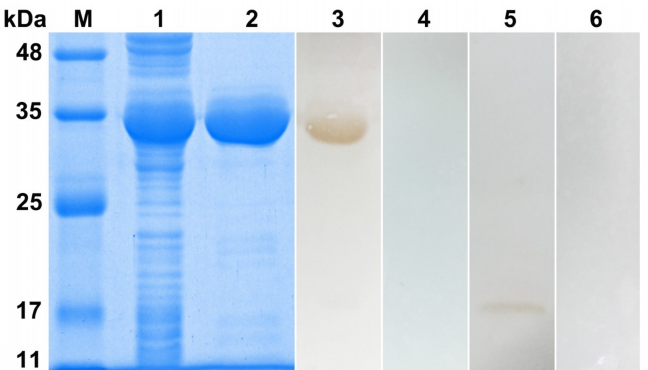
Figure 3. Sodium dodecyl sulphate–polyacrylamide gel electrophoresis (SDS-PAGE) and Western blotting analysis of Di -CPI. M, molecular weight markers; Lane 1, IPTG-induced recombinant (r) Di -CPI in Escherichia coli BL21 (DE3); Lane 2, purified r Di -CPI (6 µ g); Lane 3, purified r Di -CPI probed with serum from a dog naturally infected with D. immitis (6 µ g); Lane 4, purified r Di -CPI probed with naive dog serum; Lane 5, total protein from D. immitis probed with anti-r Di -CPI serum (20 µ g); Lane 6, total protein from D. immitis probed with native (preimmune) rabbit serum (20 µ g).